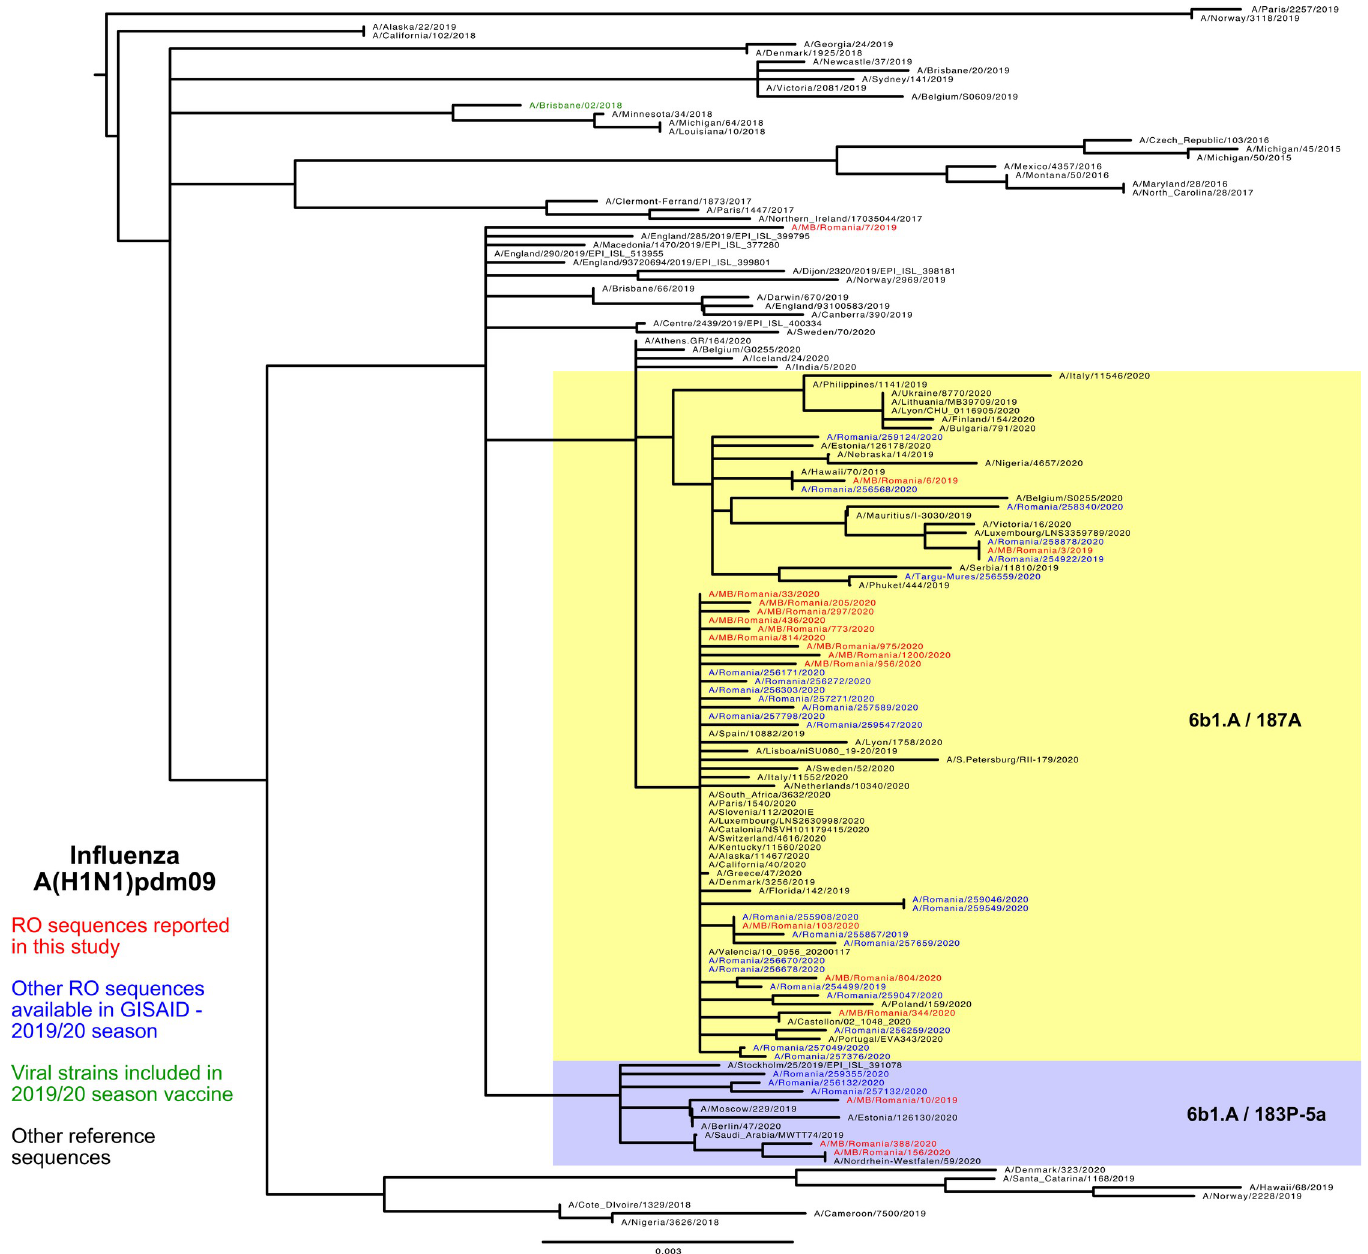
Fig 3. Phylogenetic analysis of A(H1N1)pdm09 hemagglutinin sequences.